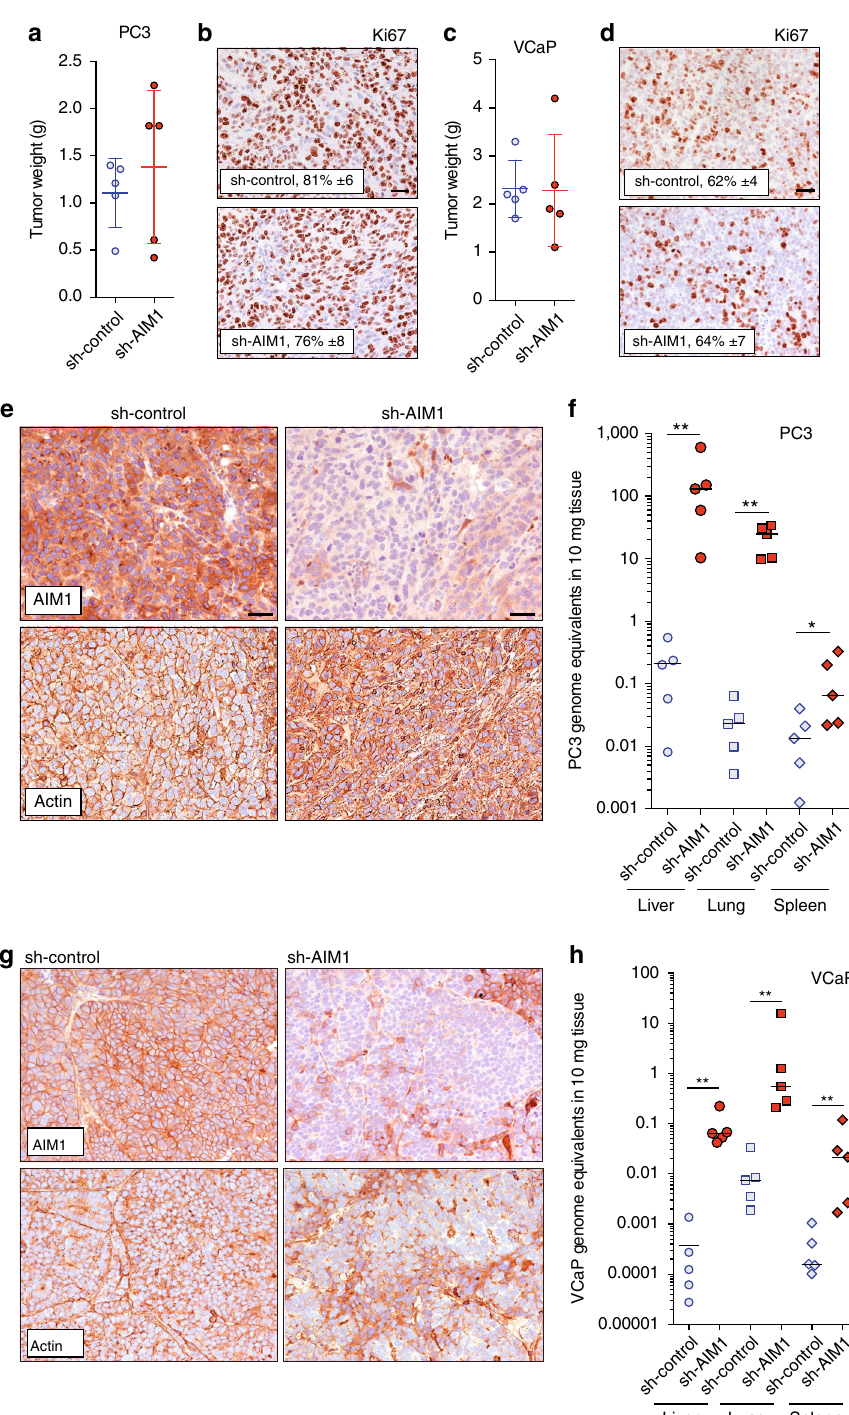
Fig. 6 AIM1 depletion results in increased micrometastatic dissemination in vivo. Xenograft tumors derived from sh-control and sh-AIM1 expressing PC3 and VCaP prostate cancer cell lines ( fi ve animals per group) were grown in the fl ank of nude mice for 4 and 6 weeks, respectively. a , c Tumor weights at the time of necropsy of PC3 and VCaP xenografts. Note that there was no statistically signi fi cant difference in end of study tumor weights between sh-control and sh-AIM1 xenografts of PC3 and VCaP cells. b , d Cell proliferation as determined by Ki67 immunostaining is not different in sh-control and sh-AIM1 xenografts. The percentage of Ki67 positive cells is indicated. Scale bars indicate 50 μ m. e Representative micrographs of immunostains for AIM1 and actin in PC3 sh-control and sh-AIM1 xenograft tumors demonstrate signi fi cant depletion of AIM1 protein levels in sh-AIM1 tumors and increased cytoplasmic staining of actin. Scale bars indicate 50 μ m. f Micrometastatic burden, measured as PC3 cell equivalents, as determined by Alu -speci fi c quantitative PCR in liver, lung and spleen from sh-control and sh-AIM1 PC3 xenograft bearing animals ( n = 5 in each group). g Representative micrographs of immunostains for AIM1 and actin in VCaP sh-control and sh-AIM1 xenograft tumors demonstrate signi fi cant depletion of AIM1 protein levels in sh-AIM1 tumors and increased cytoplasmic staining of actin. h Micrometastatic burden, measured as VCaP cell equivalents, as determined by Alu -speci fi c quantitative PCR in liver, lung and spleen from sh-control and sh-AIM1 bearing animals ( n = 5 in each group). * P < 0.05, ** P < 0.01 ( t -test P